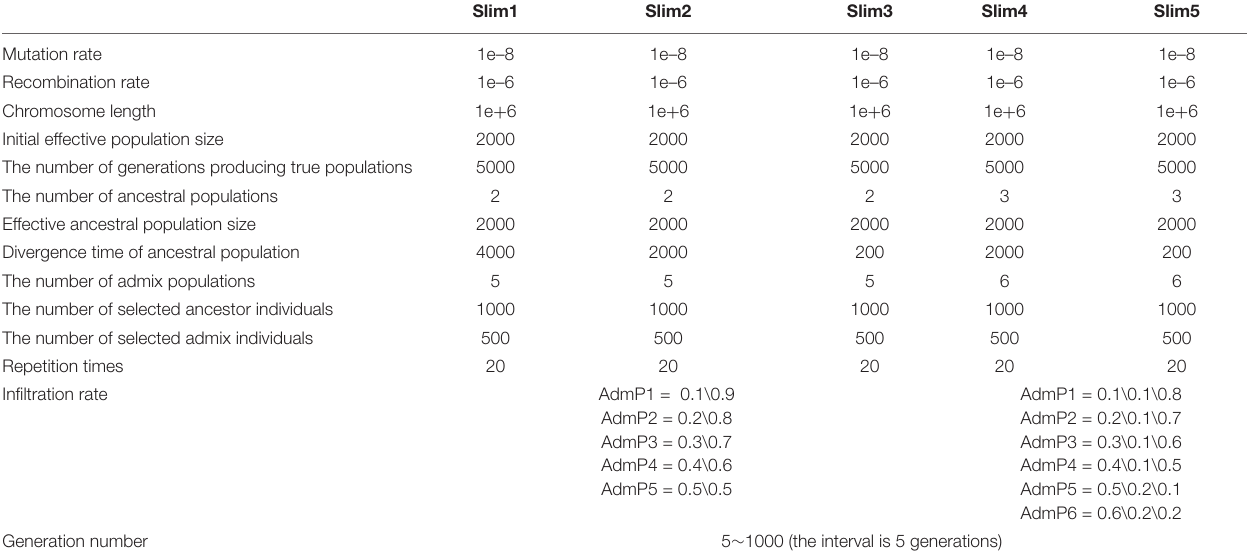
TABLE 2 | Details for generating slim data.